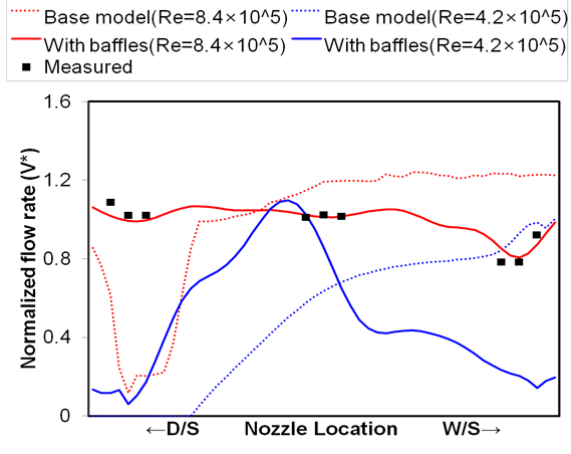
Figure 6. Water distribution comparison between base model and model with the baffles.